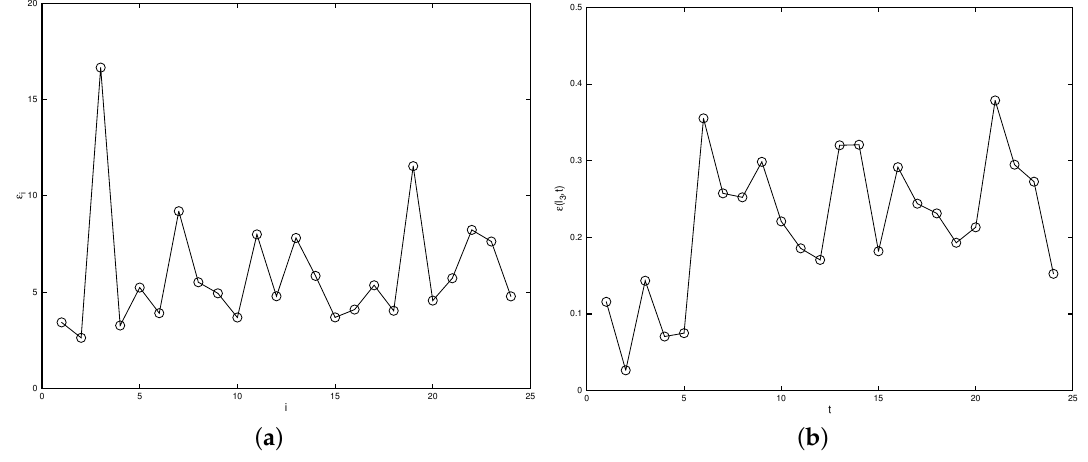
Figure 8. Detecting the malfunctioning sensor by examining ε ( l i , t ) when the error of the sensor is 25%. ( a ) ε i for all i ; ( b ) ε ( l 3 , t ) for all t .